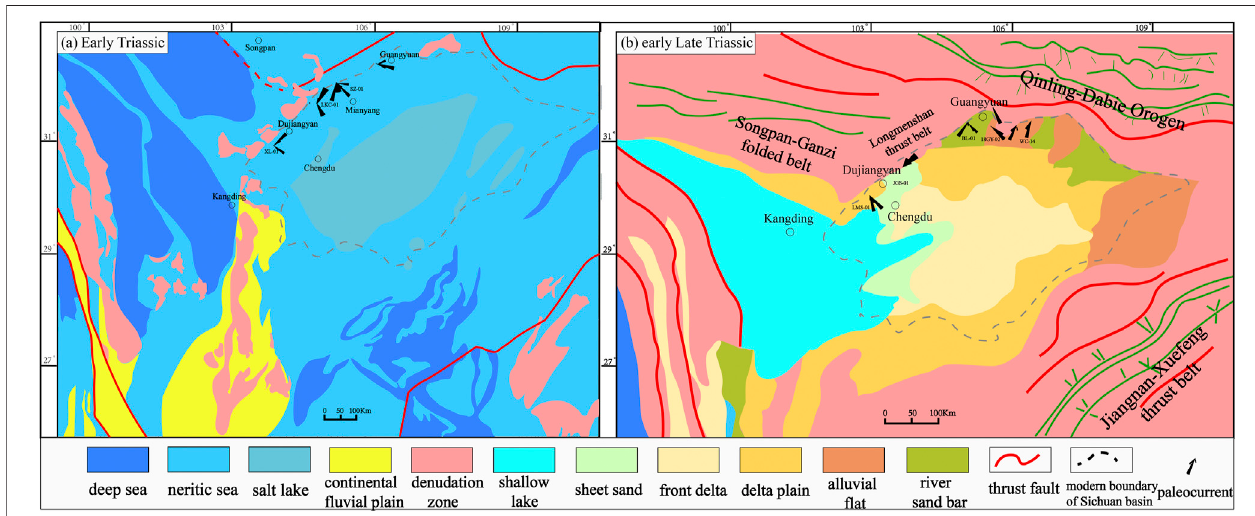
FIGURE 10 | Paleographic and paleocurrent direction distribution maps of the Early Triassic (A) and Late Triassic (B) (refer to Wang, 1985; Cui, 2004; Ma et al., 2009; Zhu et al., 2017).